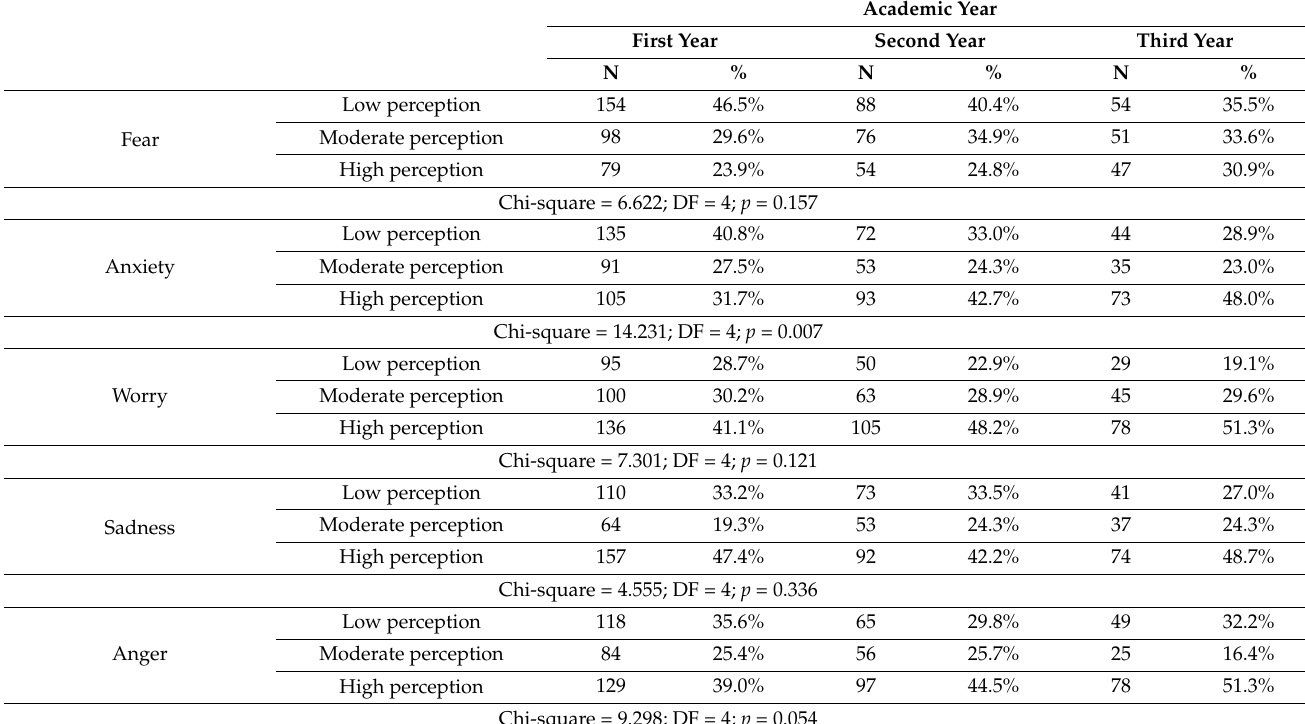
Table 3. Frequency distribution for Academic year about the perceived